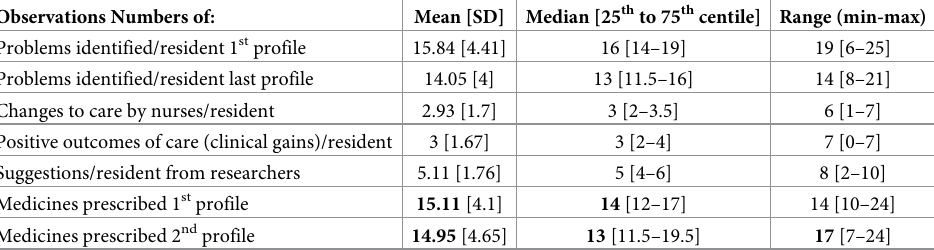
Table 1. Summary of outcomes for residents (n =